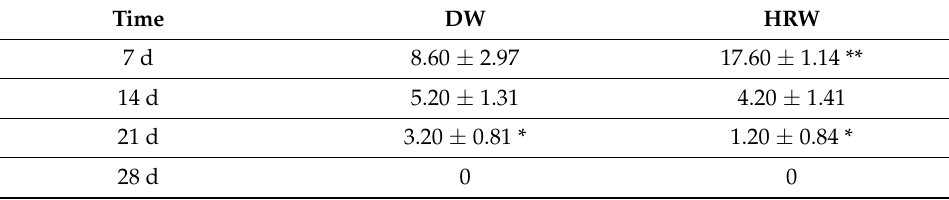
Table 4. The number of neovascular structures in DW and HRW groups at days 7, 14, 21, and 28. * p < 0.05, ** p < 0.01. Time